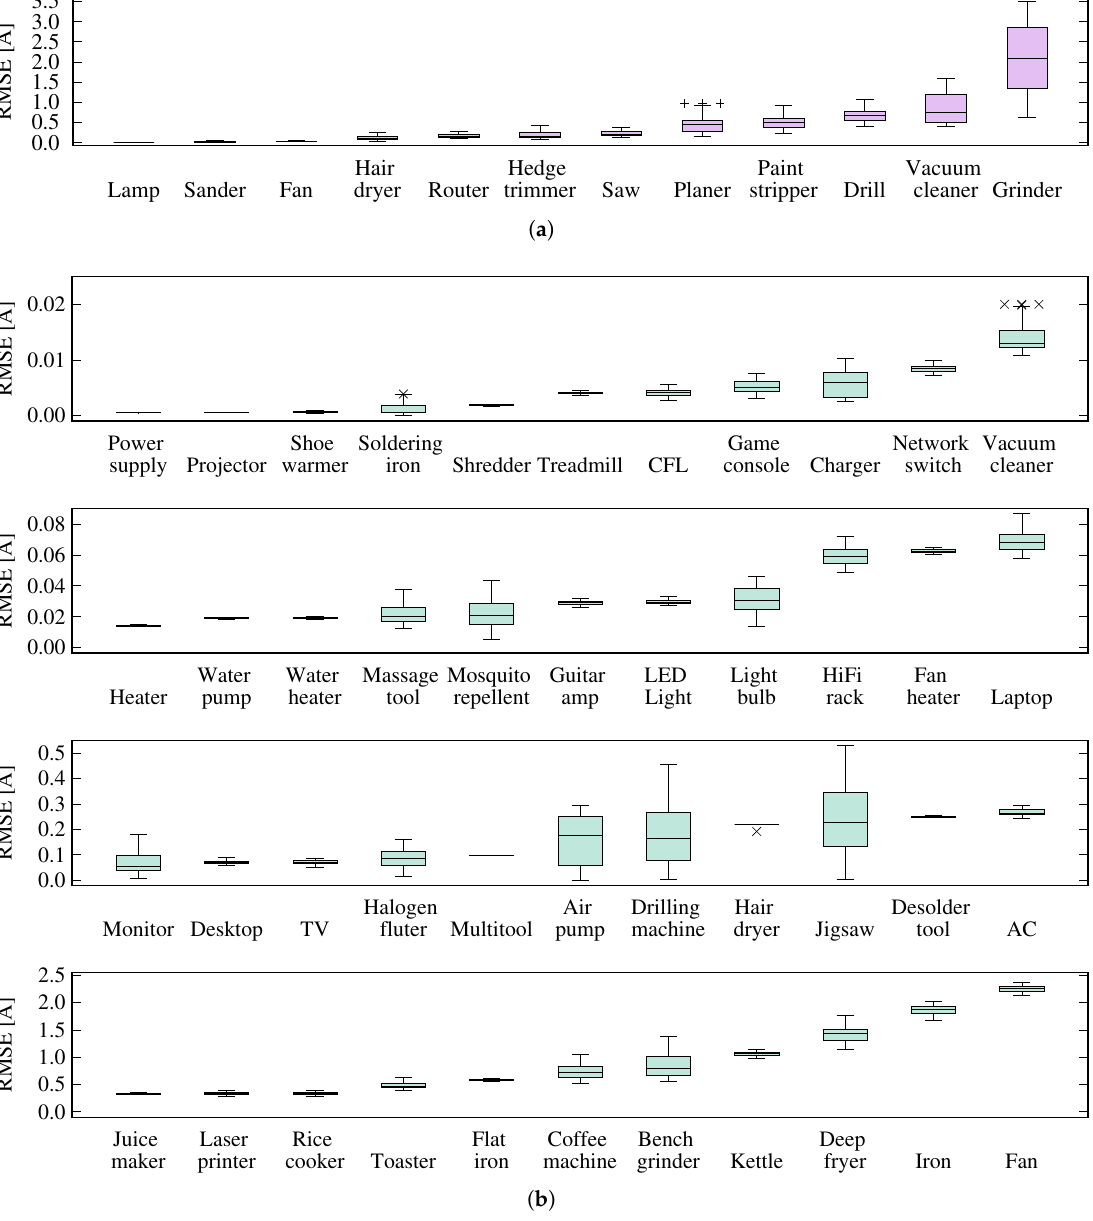
Figure 10. Absolute reconstruction RMSE for each appliance type. ( a ) COOLL data set (using a library size of 7 templates); ( b ) WHITED data set (using 23